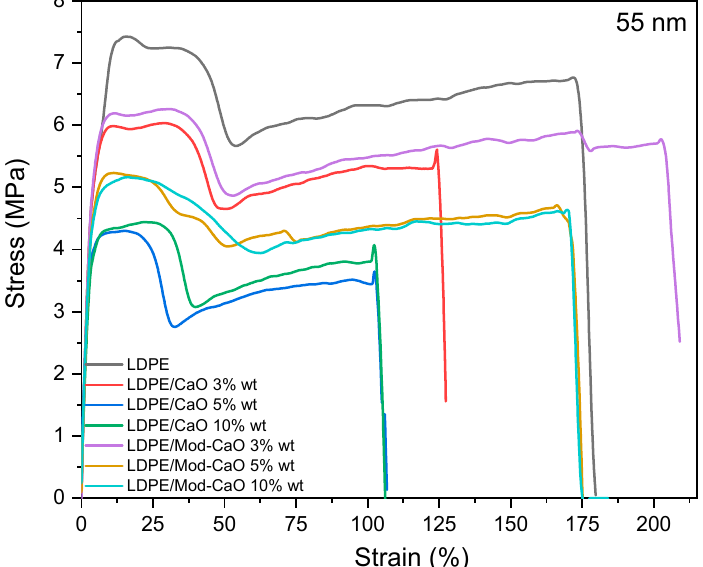
Figure 7. Stress–strain curves of LDPE, LDPE/CaO, and LDPE/Mod-CaO with CaO nanoparticles ca. 55 nm.